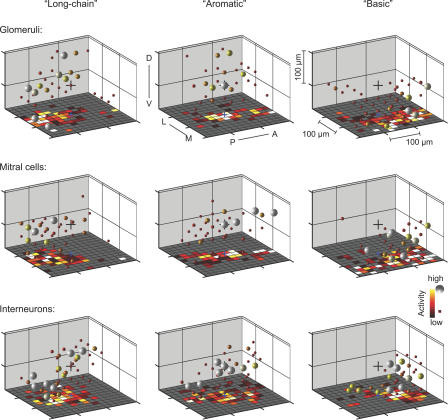
Stereotyped Chemotopy during the Initial Phase of the Odor ResponseThree-dimensional plots of factors representing distinct molecular features (long-chain, aromatic, and basic), averaged over individuals, during the early phase of the odor response. Factors were extracted from glomerular activity patterns (raw Ca2+ signals time-averaged between 0 and 2 s; dataset 1) and from MC and IN activity patterns (TDCa signals time-averaged between 0 and 768 ms; datasets 1 and 2) in individual OBs. Activity of factors was then binned in 40 × 40 × 40-μm3 voxels, centered on the centroid of the aromatic factor, and averaged over animals. Spheres represent voxels; color and size of spheres indicate average activity in each voxel. Voxels with activity smaller than an arbitrary threshold are not shown. Black cross indicates the centroid of the aromatic factor. Floor patterns are projections of three-dimensional activity distributions, binned in 20 × 20 × 20-μm3 voxels, onto the horizontal plane. Orientation is as indicated: posterior to anterior (P–A), lateral to medial (L–M), and dorsal to ventral (D–V). Blue cross indicates the centroid of the aromatic factor in the horizontal plane. Distinct volumes of dense activity in different factors are segregated along the anterior–ventral to posterior–dorsal axis. The topological organization of averaged factors is similar for glomeruli, MCs and INs, showing that chemotopic maps during the early phase of an odor response are topologically related across layers and stereotyped between animals.